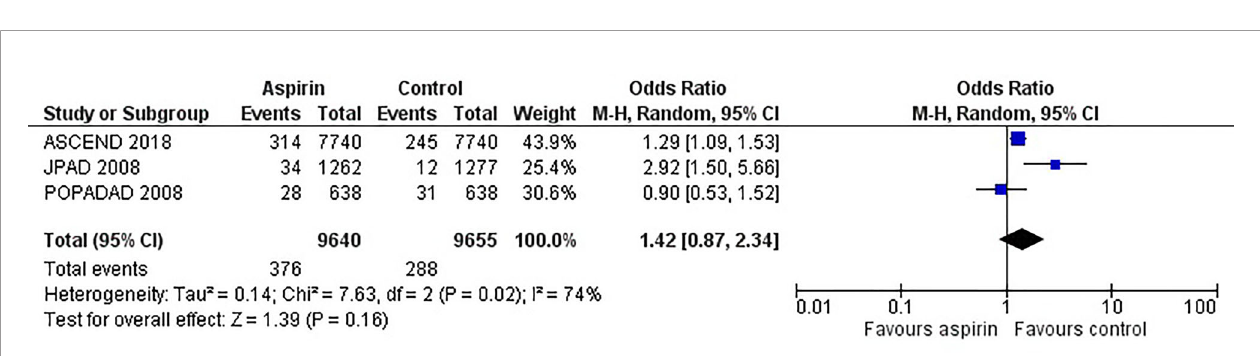
FIGURE 3 | Forest plot for the outcome of cardiovascular mortality using a random-effects model. Odds ratios and 95% con fi dence intervals are shown. Control: placebo or no treatment.